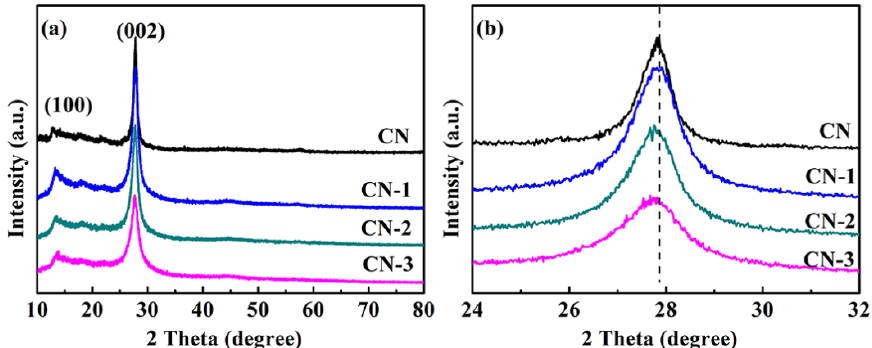
Figure 1. ( a ) XRD patterns and ( b ) the enlarged (002) peak of the CN, CN-1, CN-2, and CN-3 sam- ples